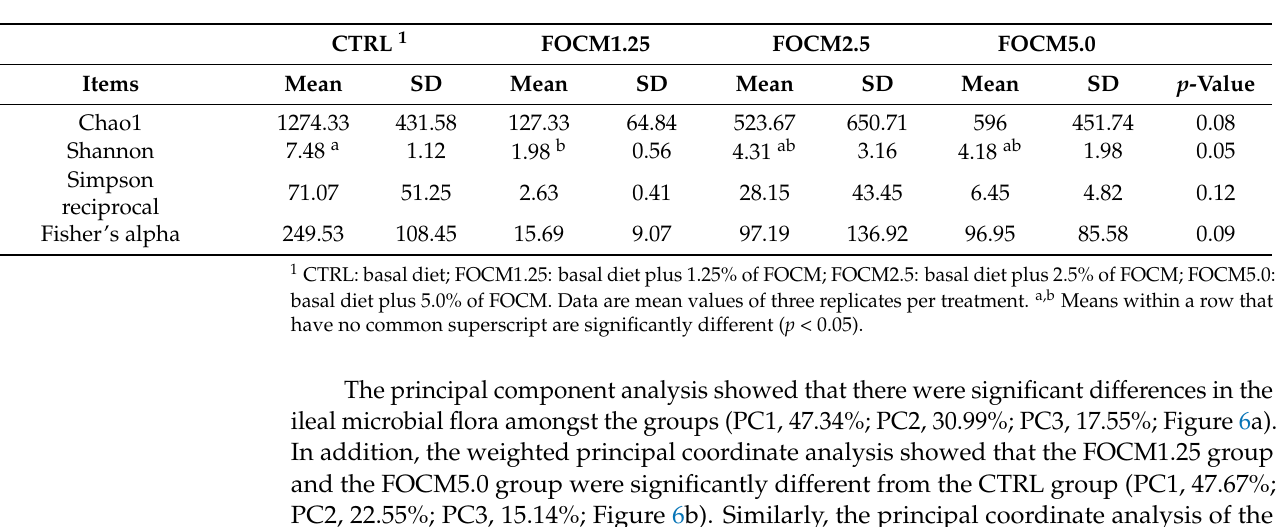
Figure 6. Comparison of the bacteria communities of the ileal contents by advanced analysis. Prin- cipal component analysis ( a ) plots of basal diet as the control (CTRL), basal diet plus 1.25% of FOCM (FOCM1.25), basal diet plus 2.5% of FOCM (FOCM2.5), and basal diet plus 5.0% of FOCM (FOCM5.0) ( n = 3). Principal coordinate analysis of weighted UniFrac ( b ) and unweighted UniFrac ( c ) distance of the ileum bacterial communities from CTRL, FOCM1.25, FOCM2.5, and FOCM5.0 ( n = 3).